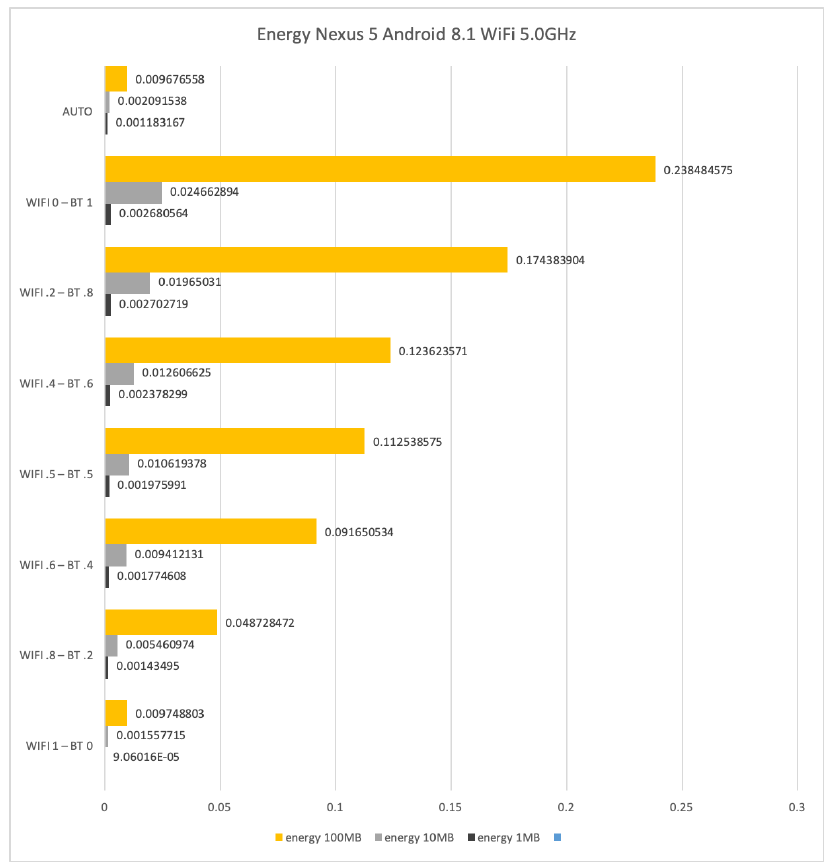
Figure 21. Time required for transferring files of size 1 Mb, 10 Mb and 100 Mb by means of WiFi at 5 GHz and Bluetooth on a LG Nexus